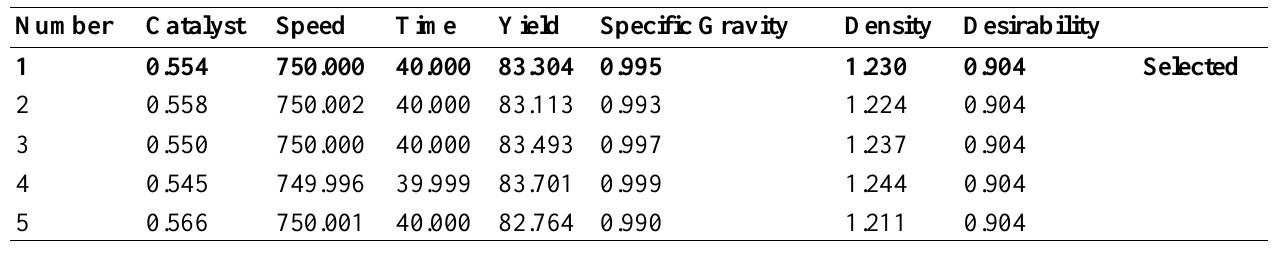
Table 7: Optimization solutions found according to the biodiesel optimization